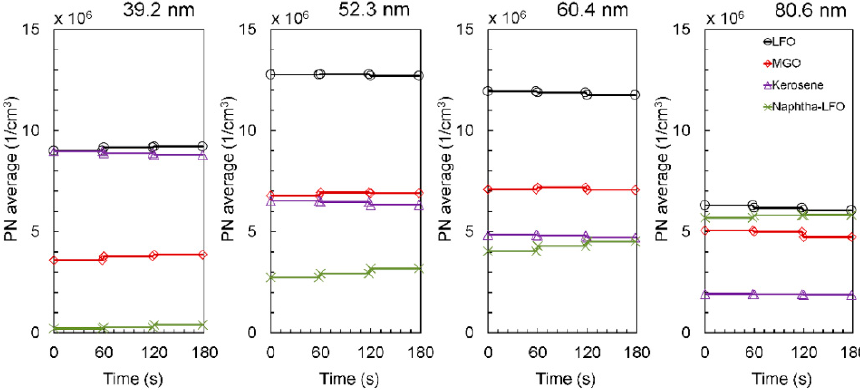
Figure 10. The average particle number between the three consecutive one-minute EEPS scans at the four four channels.